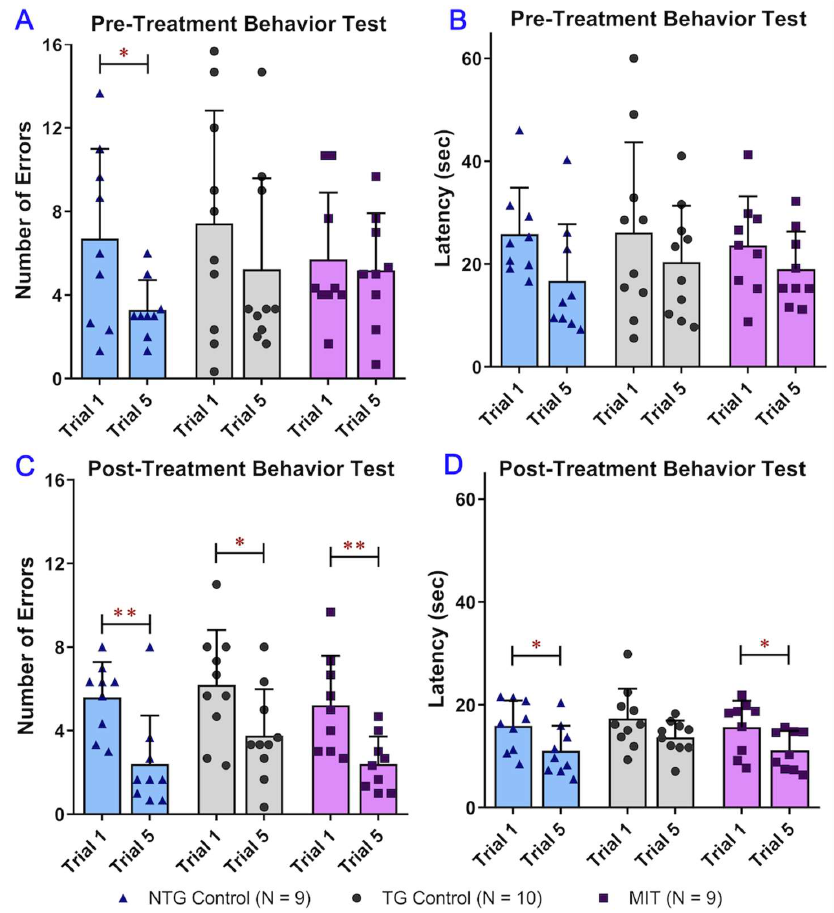
Figure 1. Evaluation of the spatial reference memory of 12-month-old wild-type C57BL/6 mice and transgenic APP/PS1 mice using the radial arm water maze (RAWM) test. C57BL/6 mice and transgenic APP/PS1 mice were divided into three study groups, i.e., the non-transgenic control (NTG), transgenic APP/PS1 (TG) control, and TG MIT treatment groups, and treated with vehicle control or MIT once daily for 3 months. The cognitive performances of NTG and TG mice were presented as trials of the number of errors and escape latency. Both parameters demonstrated the difference in cognitive performance at the learning phase—Trial 1—and at the memory phase—Trial 5. The values are expressed as means ± standard deviation (SD) (N = 9 for the NTG control group, N = 10 for the TG control groups, and N = 9 for the TG MIT treatment group). SD is denoted by error bars. A comparison of ( A ) baseline number of errors, ( B ) baseline latency, ( C ) the post-treatment number of errors, and ( D ) the post-treatment latency between Trial 1 and Trial 5 demonstrated a significant decrease in baseline number of errors ( p < 0.05), post-treatment number of errors ( p < 0.01), and latency ( p < 0.05) in NTG control mice; a significant decrease in the post-treatment number of errors ( p < 0.05) in TG control mice; and a significant decrease in the post-treatment number of errors ( p < 0.01) and latency ( p < 0.05) in MIT-treated TG mice. One-way ANOVA followed by a Tukey’s post hoc multiple comparison test showed that there was no statistically significant difference in the number of errors and latency between the three study groups. * p < 0.05 and ** p < 0.01 compared with Trial 1 using the paired-sample t